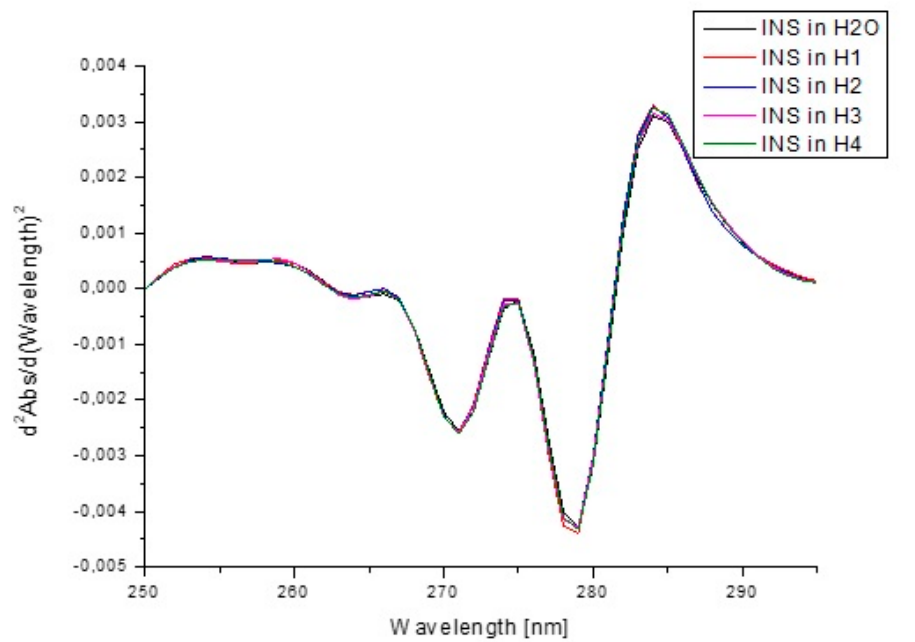
Figure 12. Second derivative absorption spectra of insulin at 1.04·10 -5 g/cm 3 concentration both in H 2 O and in the presence of model hydrogels H1-H4.